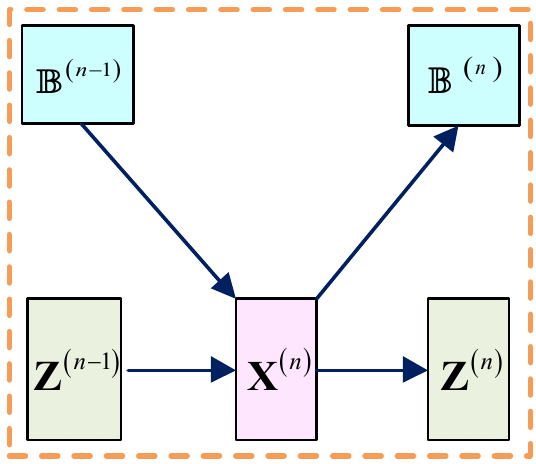
Figure 2. Reconstruction layer.